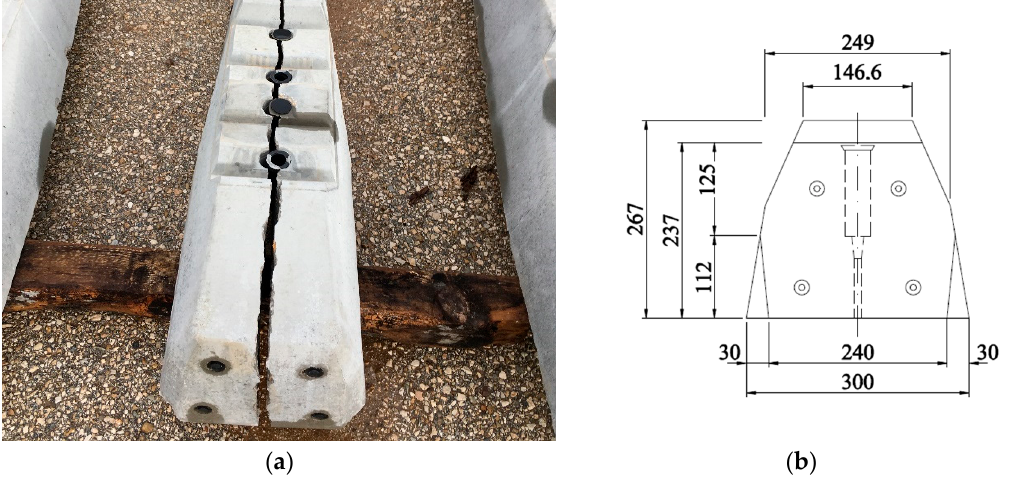
Figure 1. ( a ) Longitudinal crack in a sleeper that has completely progressed all along the element; ( b ) Dimensioned transverse elevation of the sleeper (in mm).